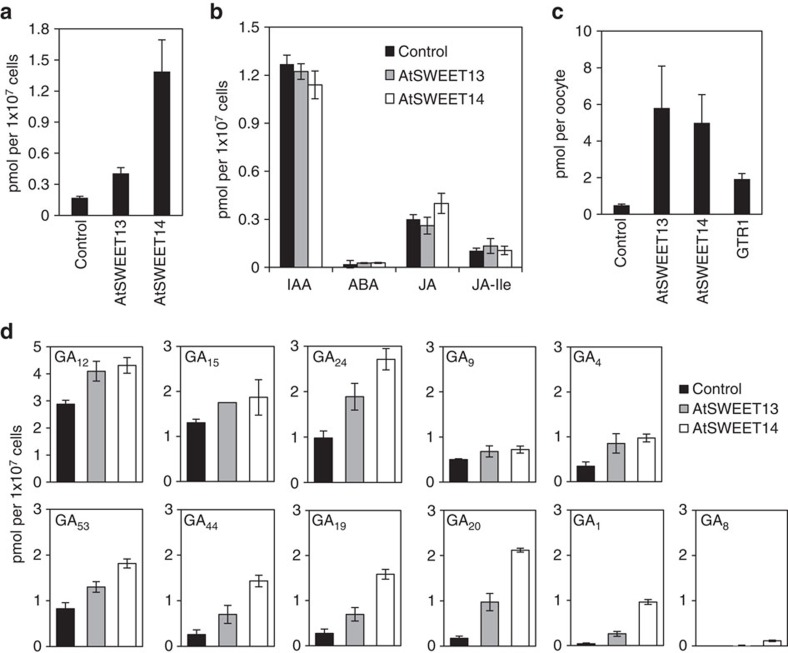
AtSWEET13 and AtSWEET14 transport GA.(a) GA transport activities of AtSWEET13 and AtSWEET14 in yeast. Yeast cells expressing AtSWEET13 or AtSWEET14 were incubated with 10 μM GA3 in the presence 100 mM glucose at pH 5.8. Yeast transformed with an empty vector was used as a control. (b) Plant hormone transport activity of AtSWET13 and AtSWEET14. Yeast cells expressing AtSWEET13 or AtSWEET14 were incubated with 10 μM IAA, ABA, JA or JA-Ile in the presence 100 mM glucose at pH 5.8. Yeast transformed with an empty vector was used as a control. (c) GA transport activities of AtSWEET13 and AtSWEET14 in Xenopus oocytes. Oocytes injected with AtSWEET13 or AtSWEET14 cRNA were incubated for 24 h in Kulori medium-based buffer (pH 5.0) containing 100 μM GA3. As a control, water was injected into the oocytes. AtNPF2.10/GTR1 cRNA was also injected for comparison. Values are means±s.d. of four biological replicates with two oocytes. (d) Substrate preferences of AtSWEET13 and AtSWEET14 for different GA species. Yeast cells expressing AtSWEET13 or AtSWEET14 were incubated with a mixture of 11 GAs (5 μM each) in the presence of 100 mM glucose at pH 5.8. Yeast transformed with an empty vector was used as a control. For (a,b,d), compounds taken into cells after incubation for 5 min were analysed by LC–MS/MS. Values are means±s.d. of three biological replicates.